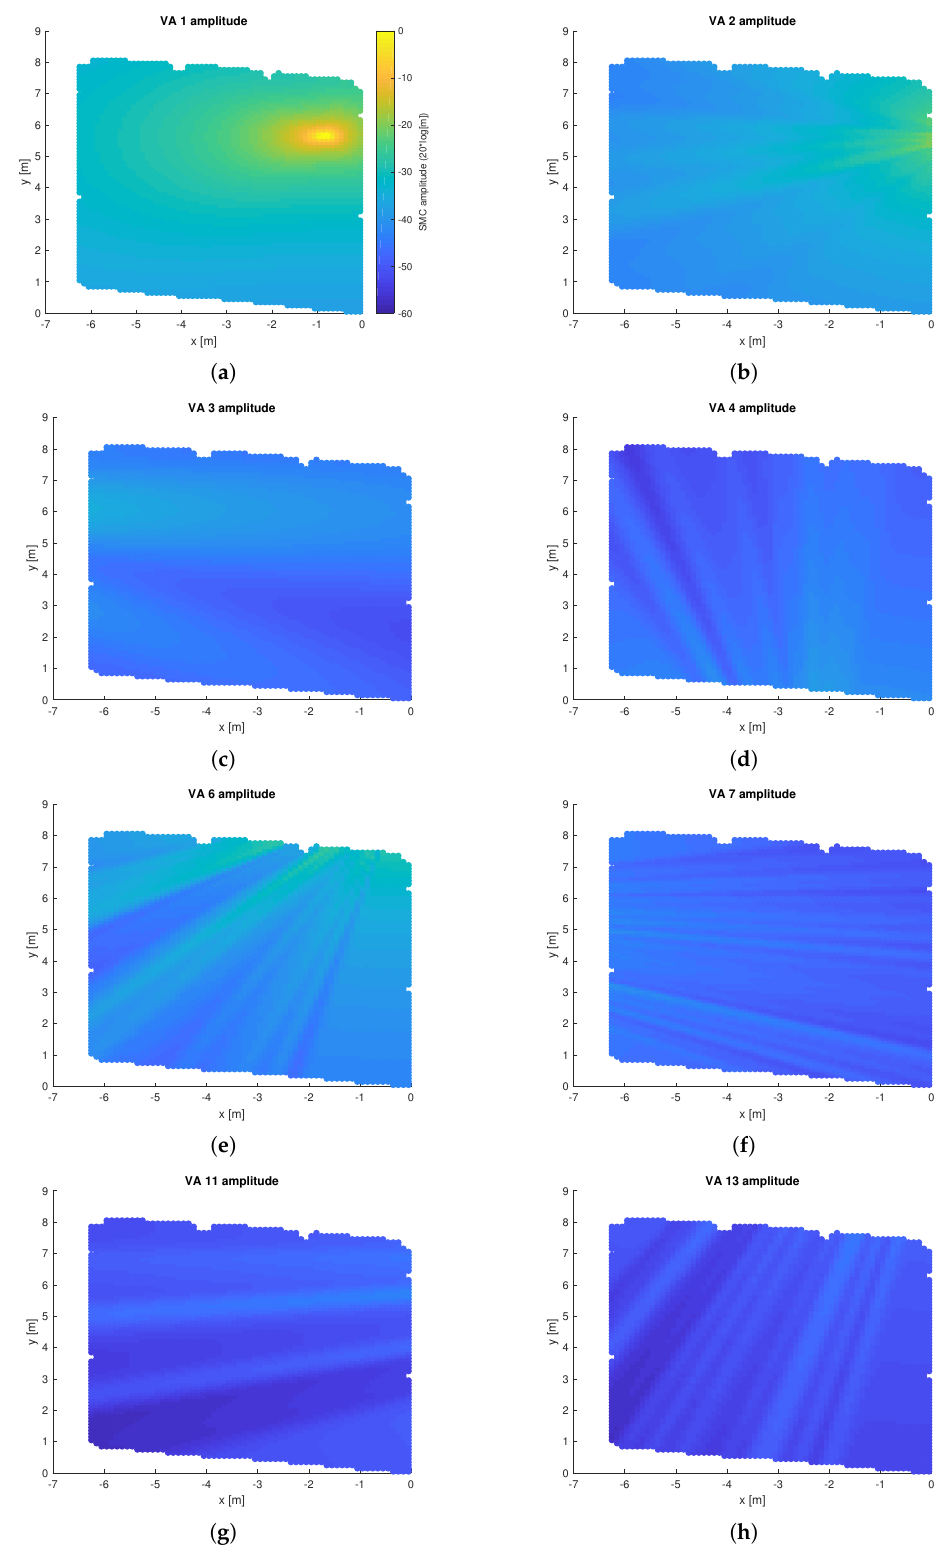
Figure 8. Predicted SMC amplitude α k ( p ) for the whole floor plan for various SMCs: ( a ) LOS, ( b ) reflection on EPB, ( c ) reflection on WW, ( d ) reflection on on south part of the room, ( e ) reflection on the north part of the room, ( f ) double reflection on EPB then WW, ( g ) double reflection on WW then EPB, ( h ) double reflection on the SW then NGW. GPR was applied the set of measurement along the trajectory. The same dB scale is used in all